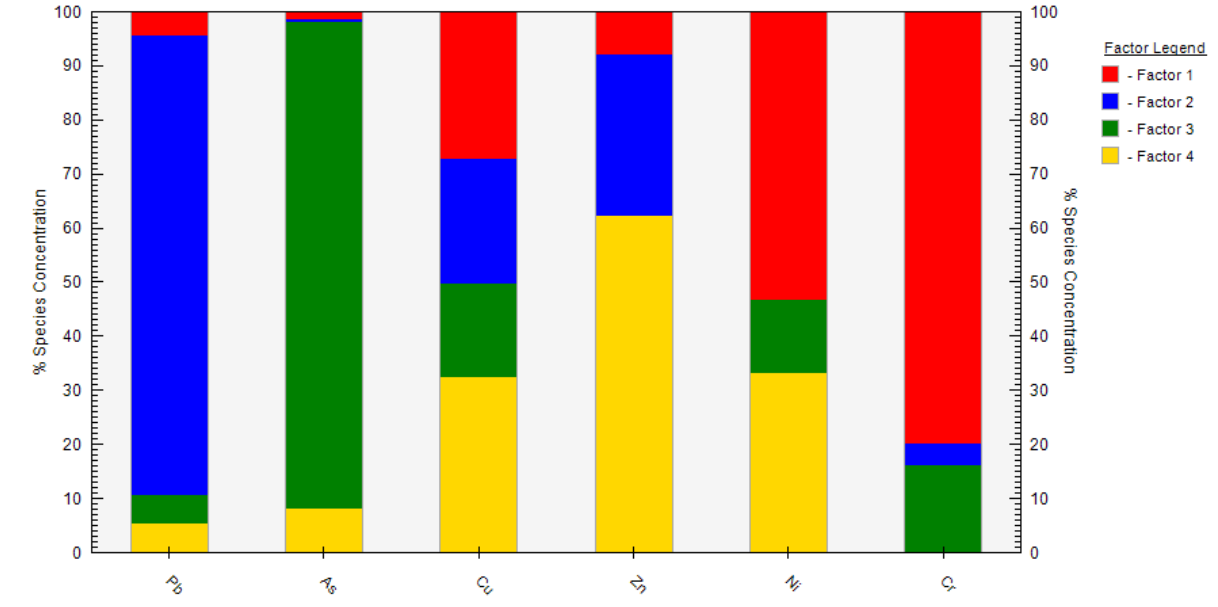
Figure 6. Contribution of each factor to different soil heavy metals.